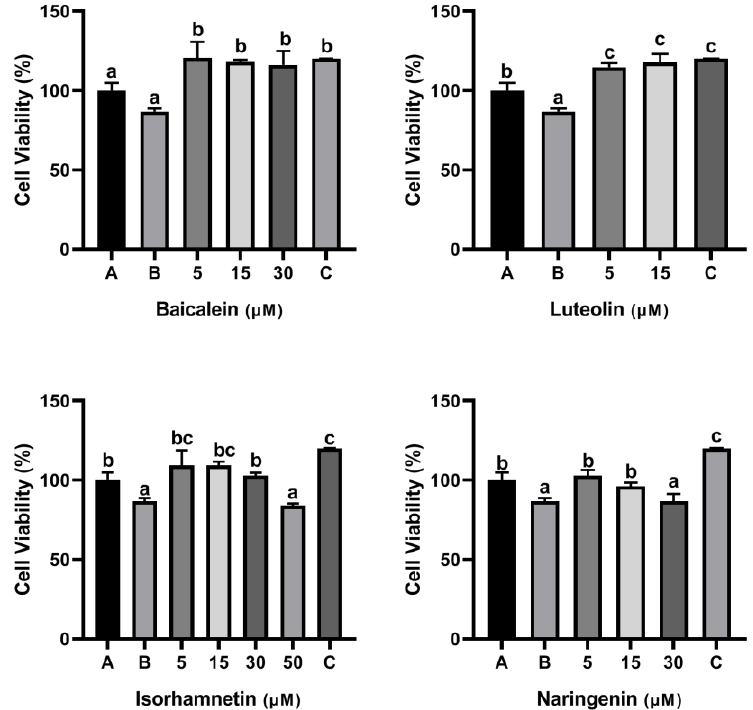
Figure 8. Effects of four flavonoids on the viability of Caco- 2 cells induced by ω -5 gliadin-derived peptide P4. A (blank group): only Caco- 2 cells; B (control group): 500 μg/mL ω -5 gliadin-derived peptide P4+Caco-2 cells; C (positive control group): 10 nM Dexamethasone+Caco-2 cells. Note: different letters indicate significant differences between groups ( p < 0.05).